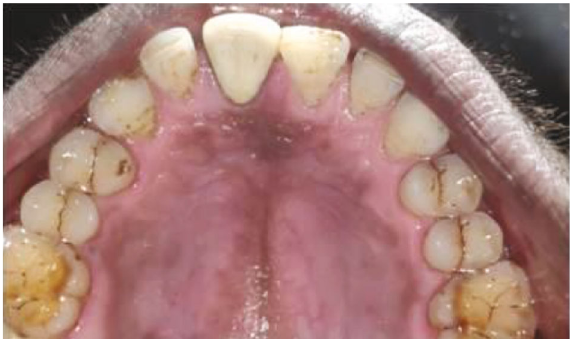
Figure 9: Palatal view photograph after 2